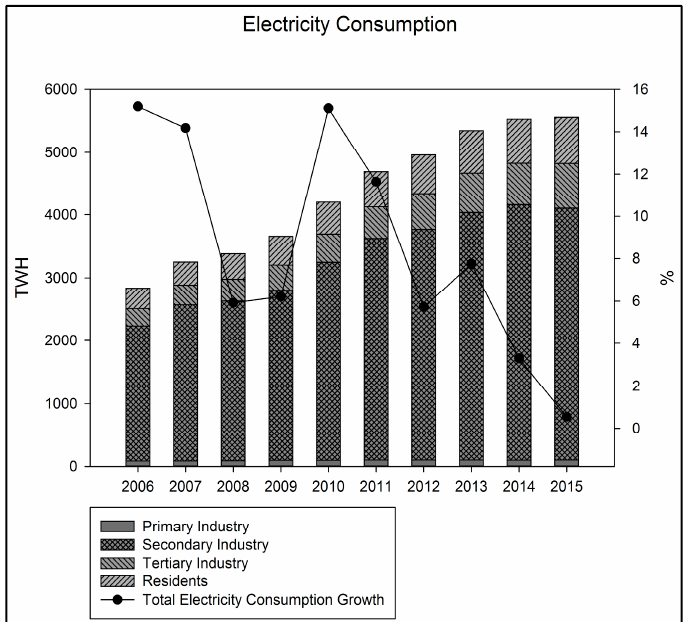
Figure 2. Electricity consumption of China from 2006 to 2015.